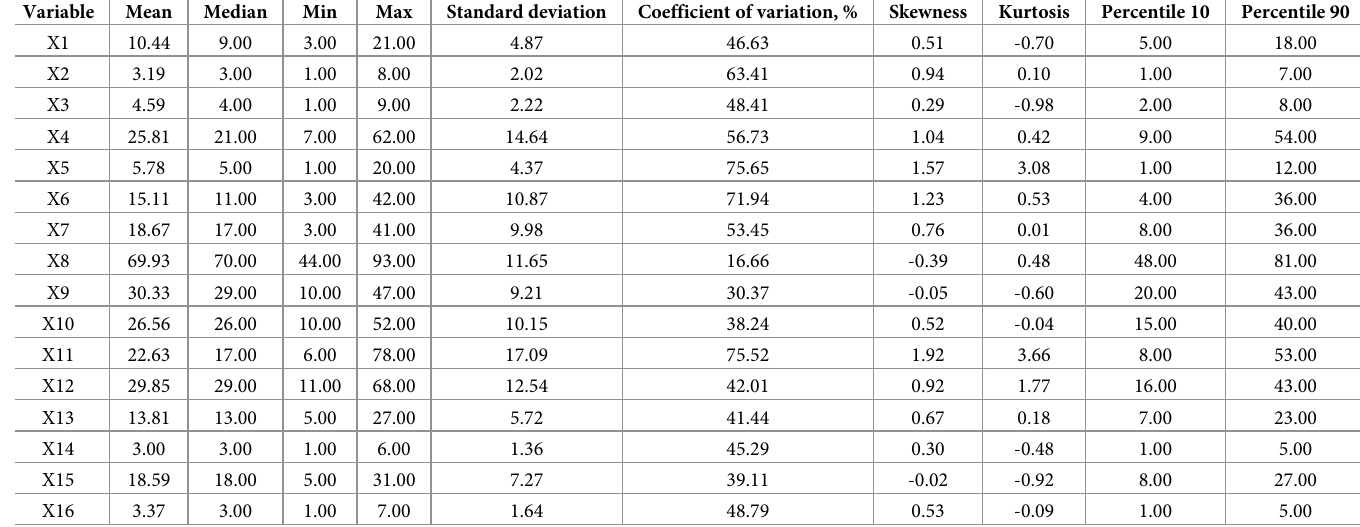
Table 3. Statistical parameters of indicators determining the level of the EU countries in terms of digitalization and robotization of small